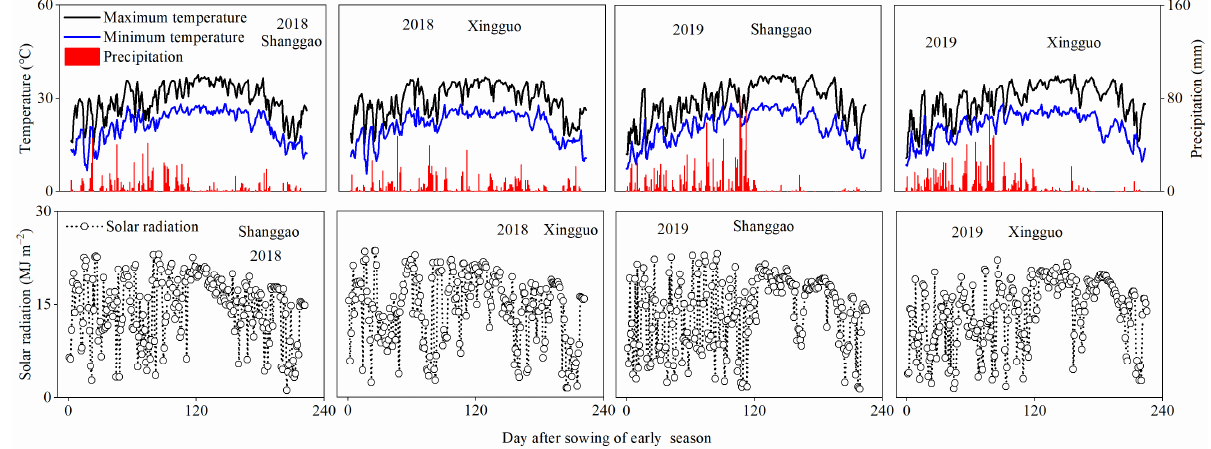
Figure 1. Solar radiation, maximum and minimum temperatures and precipitation of the early and late seasons in the two ecological regions in 2018 and 2019. late seasons in the two ecological regions in 2018 and